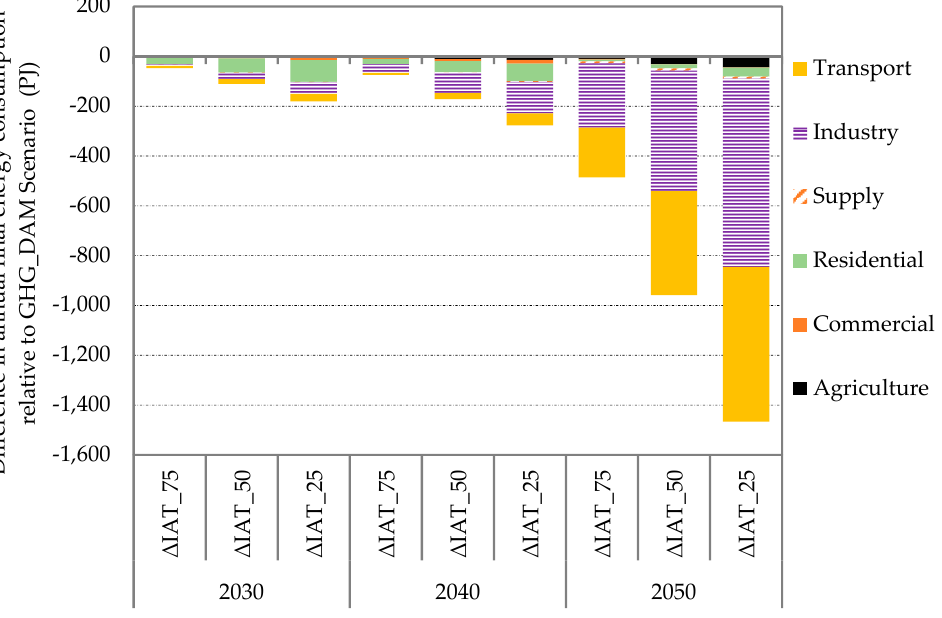
Figure 9. Di ff erence in annual final energy consumption by sector relative to GHG_DAM scenario in the EU28 (PJ).